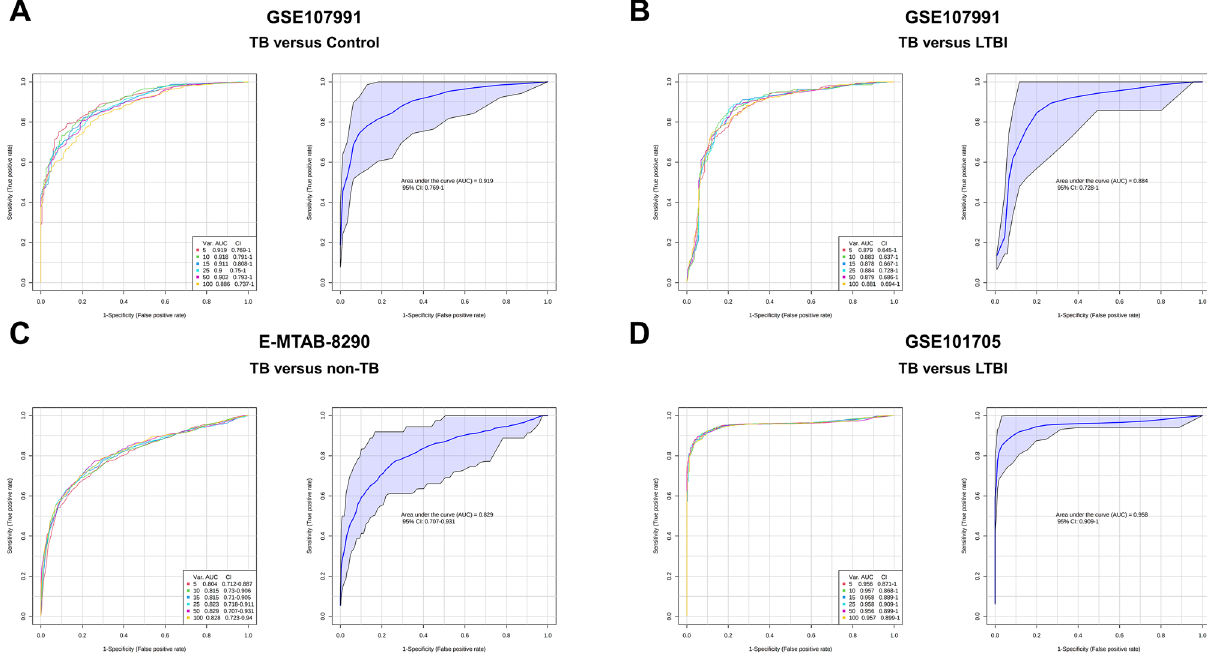
Figure 5. Tuberculosis (TB) and non-TB classification in three cohort by lipid-genes biomarkers using Random Forest predictive model. ( a ) Model performance (AUC = 0.919) of TB versus Control classification in GSE107991 dataset. ( b ) Model performance (AUC = 0.884) of TB versus latent tuberculosis infection (LTBI) classification in GSE107991 dataset. ( c ) Model performance (AUC = 0.829) of TB versus non-TB classification in E-MTAB-8290 dataset. ( d ) Model performance (AUC = 0.958) of TB versus Control classification in GSE101705 dataset. Var variable, AUC area under the curve, CI confidence interval, TB Tuberculosis, LTBI Latent tuberculosis